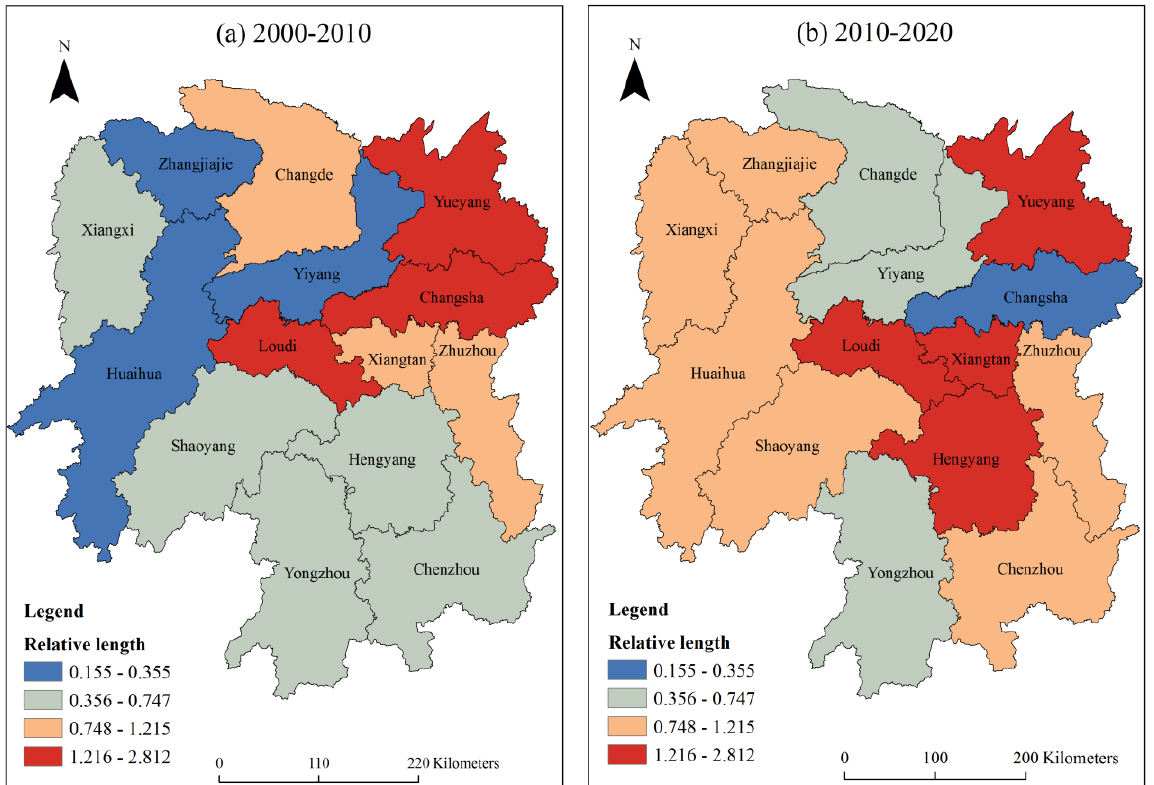
Figure 4. Spatial distribution of relative length of the LISA time path from 2000 to 2020. Similarly, the LISA time path curvature from low to high in 2000–2010 was divided into four grades by the natural breakpoint method: low curvature (1.000~1.692), medium cur- vature (1.693~2.718), high curvature (2.719~4.958) and maximum curvature (4.959~7.404). The curvature of the LISA time path from 2010 to 2020 was graded by the same classifi- cation method. As shown in Figure 5, from 2000 to 2010, Zhuzhou was a city with high curvature, indicating that Zhuzhou had a highly volatile carbon emission growth and local spatial dependence change process. Most of the urban areas in central Hunan, southern Hunan, and eastern Hunan belonged to low curvature cities, with weak volatility of carbon emission growth and local spatial dependence change process. Other urban areas had moderate curvature. From 2010 to 2020, Xiangxi became the urban area with the largest curvature, while Changde, Loudi, and Xiangtan had higher curvature, and the urban areas with the strongest volatility in the direction of spatial dependence showed an increasing trend from one in 2000 to four in 2010. The number of urban areas with low curvature showed a downward trend; that is, the number of urban areas with weak volatility of car- bon emission growth and local spatial dependence change process decreased. To sum up, the proportion of cities with low curvature and medium curvature in the two periods was more than 70%, indicating that the carbon emission growth and local spatial dependence change process in Hunan Province are relatively stable as a whole. From the perspective